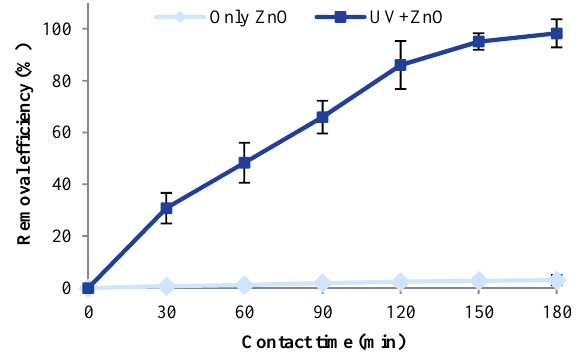
Figure 5. Comparison of the efficiency of ZnO nanoparticles alone and the UV/ZnO process in the removal of phenol (pH = 3, Phenol = 20 mg/l, and NaCl = 10